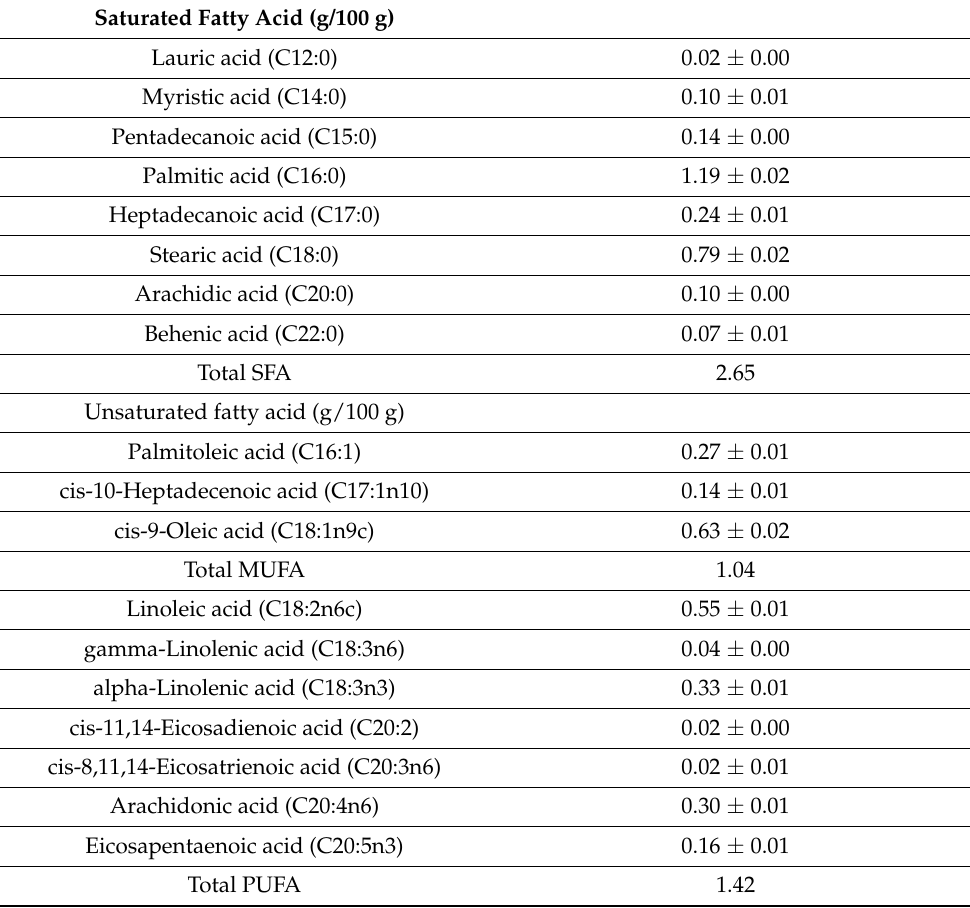
Table 2. Fatty acid composition of odonate Pantala